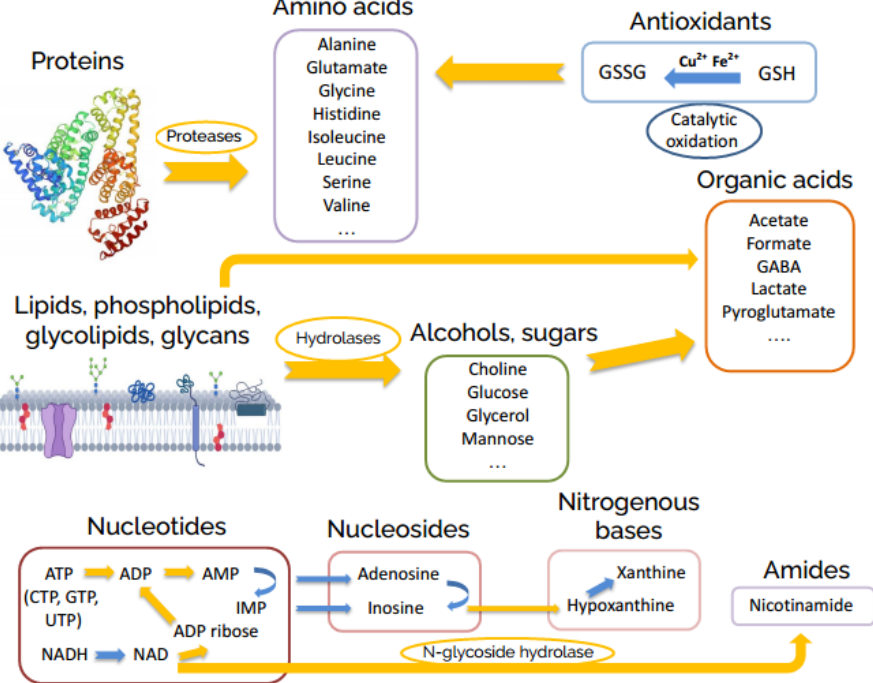
Figure 3. General scheme of post-mortem metabolite transformations in rat brain homogenates.